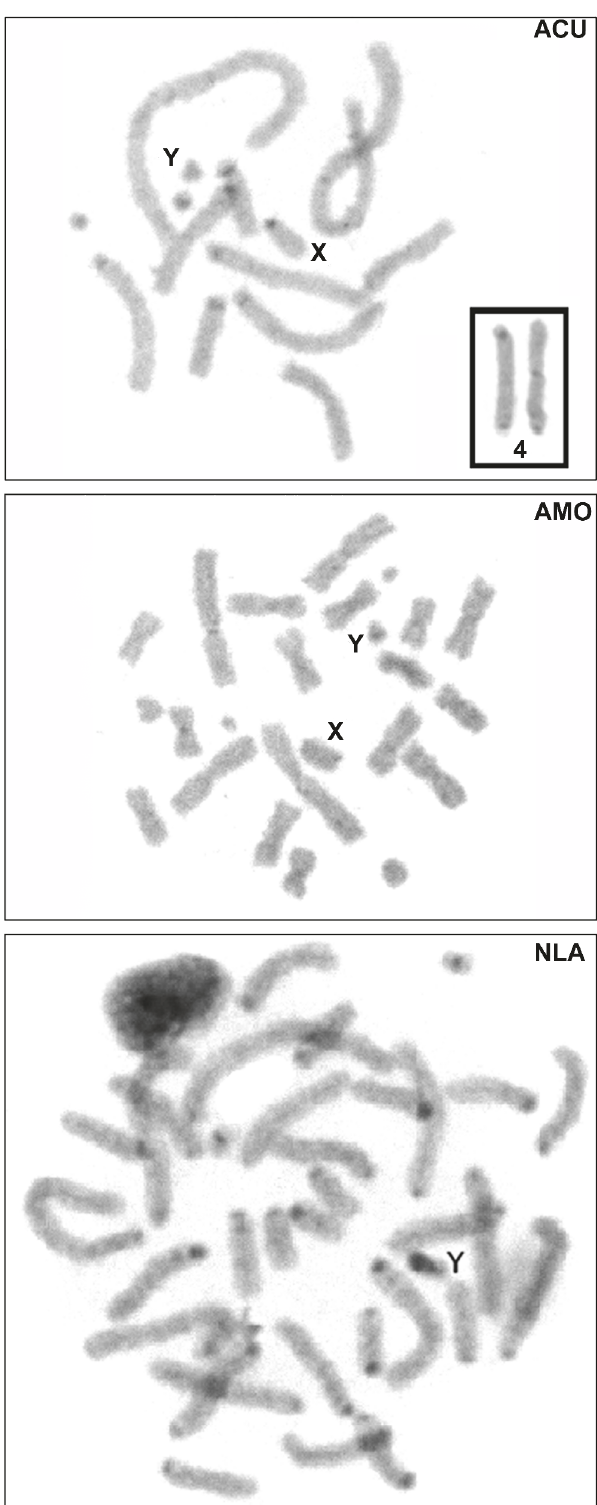
Figure 1: CBG-banded cells of Akodon cursor (ACU, 2n =14), A. montensis (AMO, 2n =24), and Necromys lasiurus (NLA, 2n=34). ACU pair 4 is shown in the